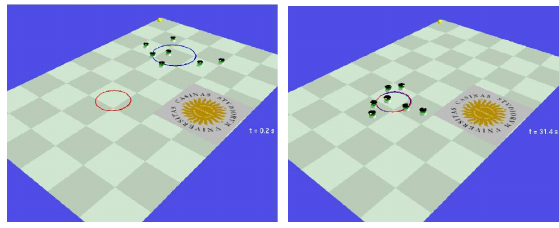
Figure 5. Reconstruction of a spread control mission execution with a team of mobile robots. The two snapshots represent the initial (left) and final (right) robots configuration, where the circles represent the measured and desired centroid position and variance.